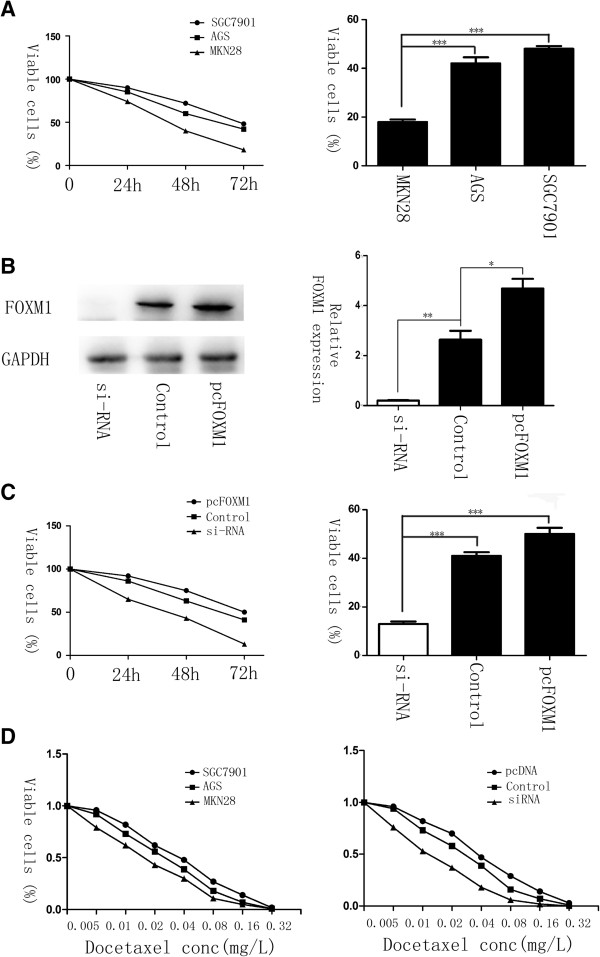
Elevated levels of FOXM1 correlate with resistance to docetaxel in gastric cancer. (A) AGS, SGC-7901 and MKN-28 cells were treated with 0.02 mg/L of docetaxel for 0, 24, 48 and 72 h. MTT assay was performed to test the cell viability. The IC50 calculations in the three cell lines were 0.034 mg/L, 0.025 mg/L and 0.016 mg/L separately (D left). (B) The expression of FOXM1 in AGS cell lines with the transfection of FOXM1-siRNA, pcDNA3,1 or pcDNA3, 1-FOXM1, analyzed by western blot 48 h later. (C) Gastric cell lines AGS were treated with docetaxel at the concentration of 0.02 mg/L after FOXM1-siRNA or pcDNA3, 1-FOXM1 transfection. Cell growth curves were drawn by MTT assays. The IC50 in FOXM1 knockdown, overexpressed and control groups was 0.012 mg/L, 0.025 mg/L and 0.038 mg/L respectively (D right). *, P ≤ 0.05; **, P ≤ 0.01; ***, P ≤ 0.001 significant.